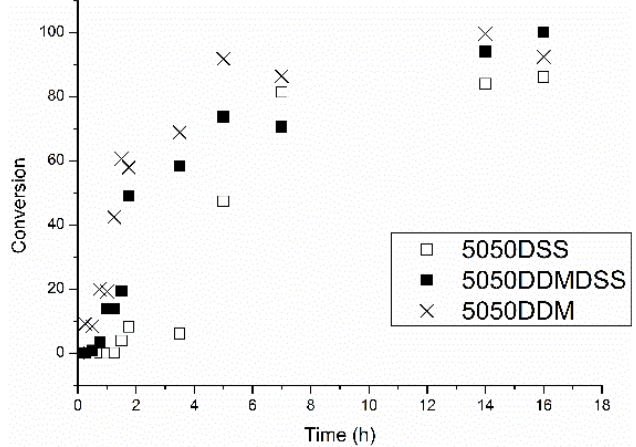
Figure 7. Conversion vs. time calculated from FTIR spectra for 50/50 DGEBA/PCL blends cured with different DDM/DSS ratios.